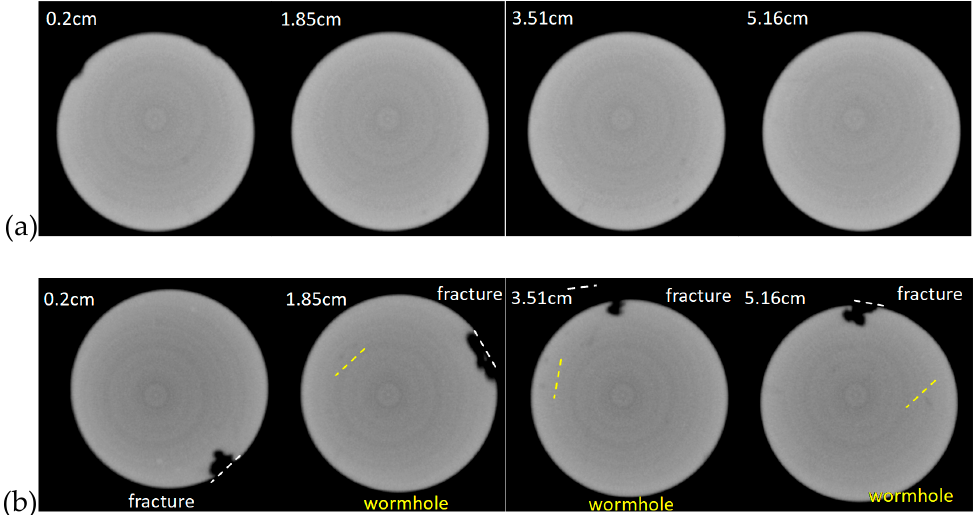
Figure 7. Industrial CT scanning on sample 37 ( a ) before and ( b ) after acid fracturing.